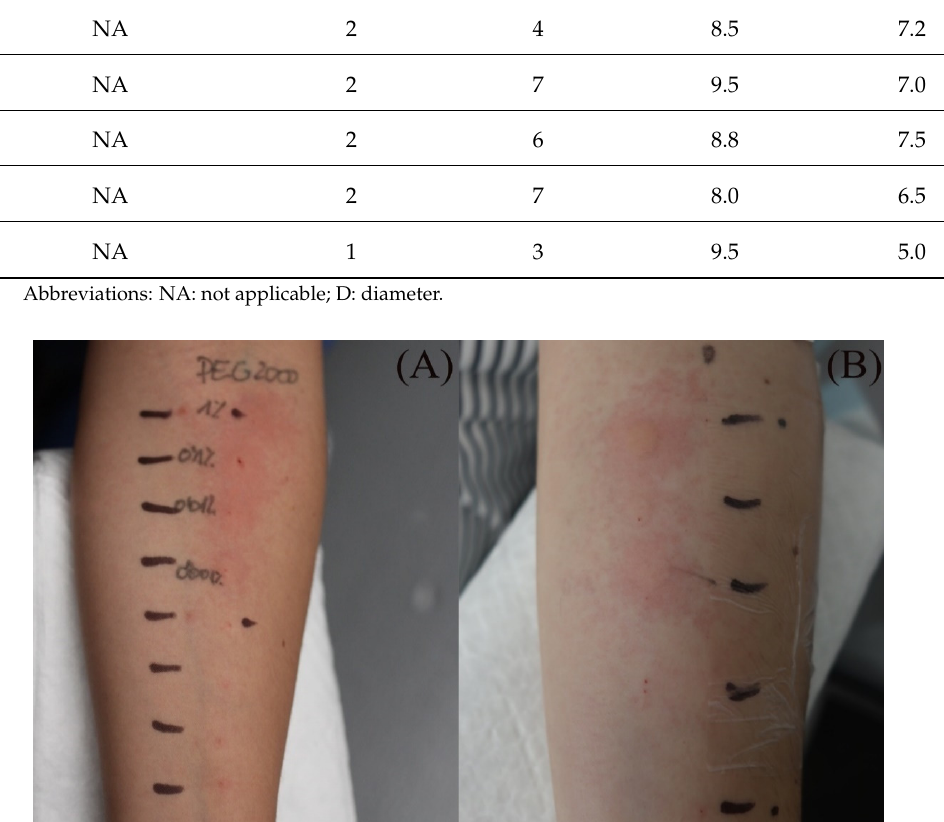
Table 3. Clinical characteristics of skin-tested patients.